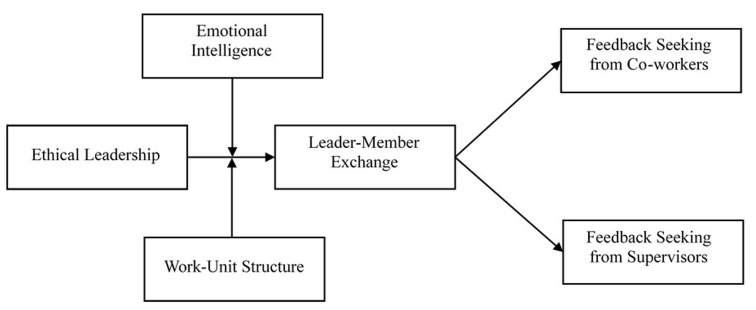
Hypothesized model.